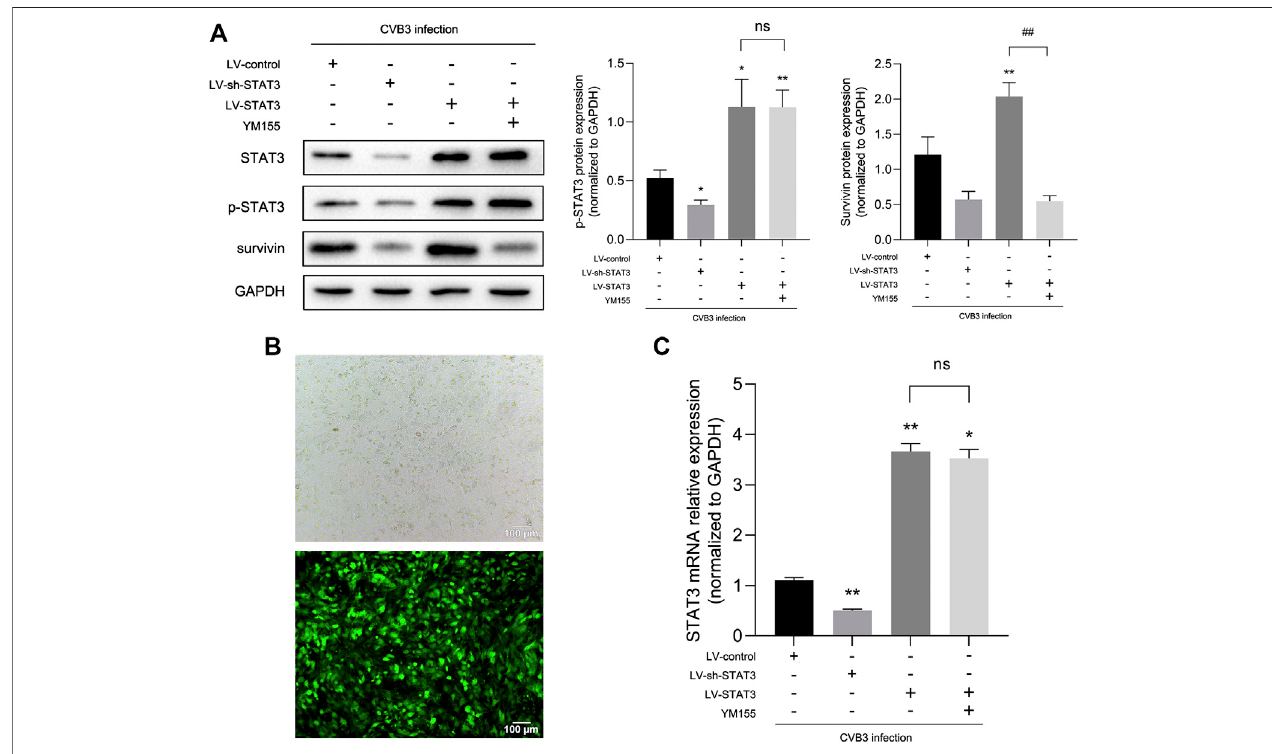
FIGURE 4 | Regulatory effects of lentiviral tools (A) The related proteins were measured by western blot ( n (cid:2) 4). (B) Expression of GFP in NMCs at 72 h after lentivirustransfection (100 × ). (C) TherelativemRNAexpression ofSTAT3 compared toGAPDH( n (cid:2) 3).* p < 0.05, ** p < 0.01vs Lv-control group,nsnosigni fi cance, # p < 0.05, ## p < 0.01 vs Lv-STAT3